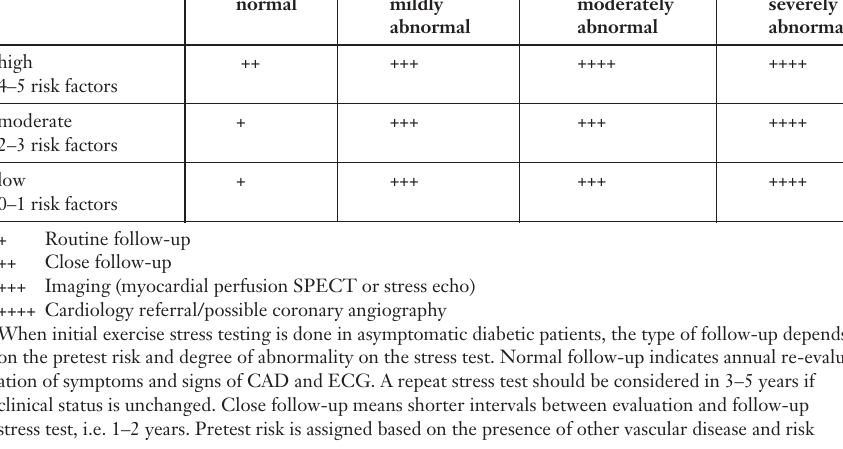
Pre-test risk exercise test results Follow-up strategies normal mildly moderately severely after screening abnormal abnormal abnormal exercise